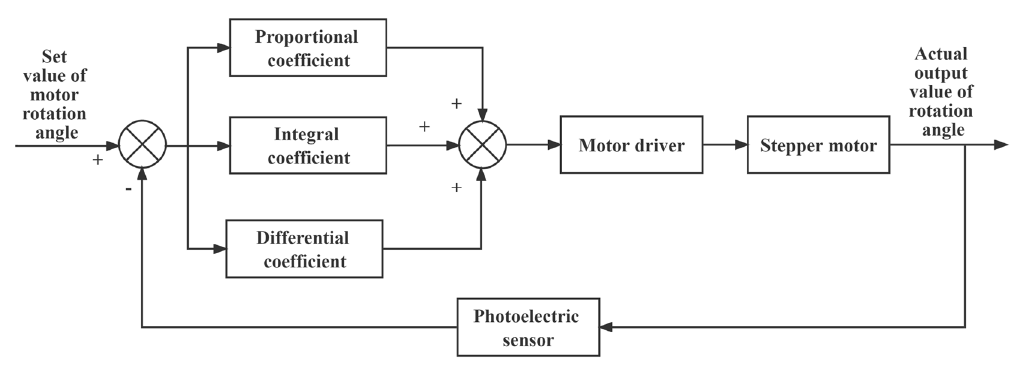
Figure 7. Position-based PID control